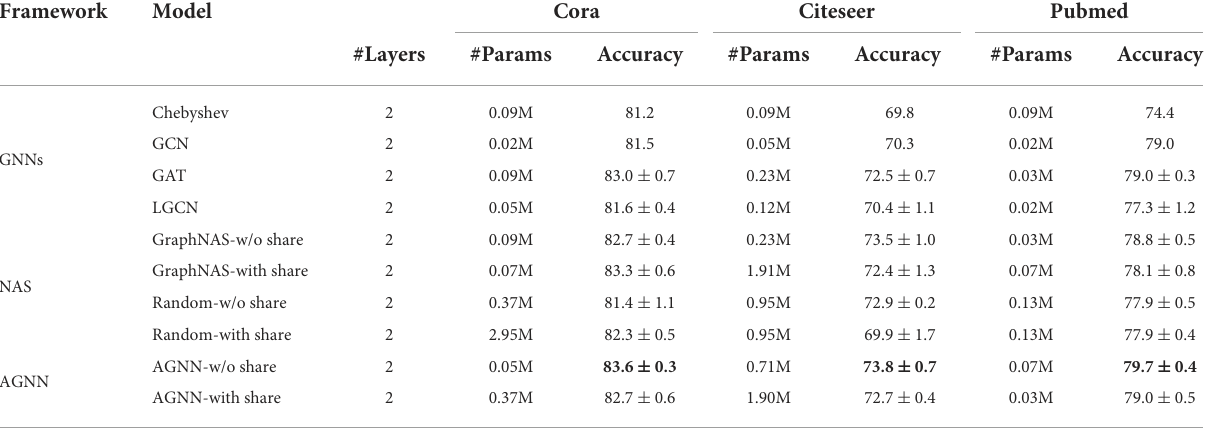
TABLE 1 Classification accuracy (in percent) under transductive learning.